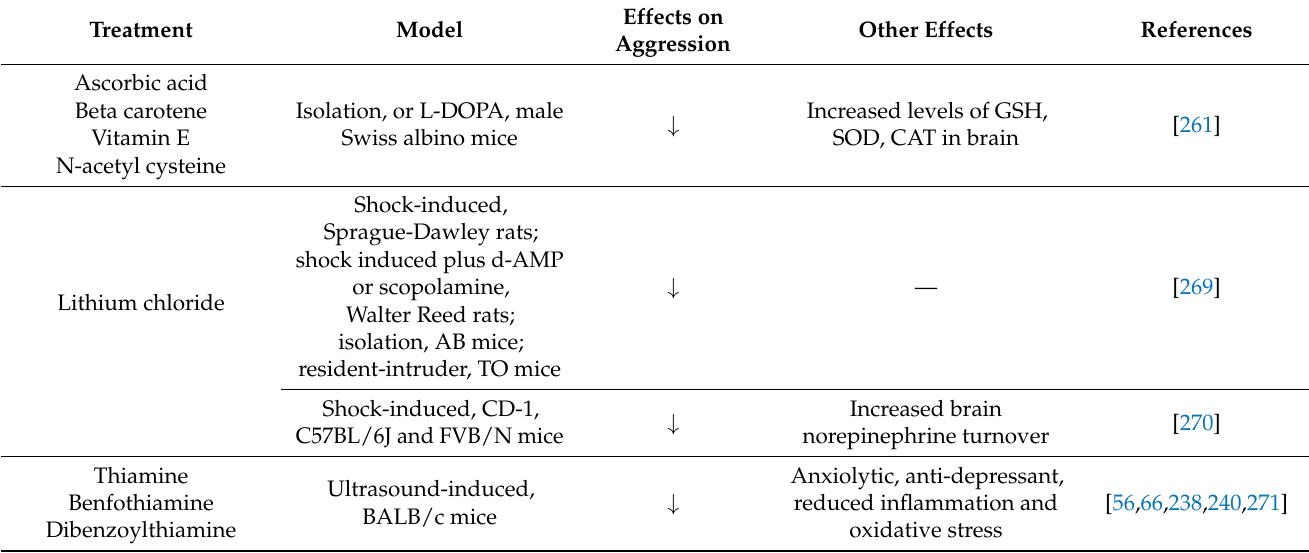
Table 3. Preclinical studies addressing the use of new treatments of excessive